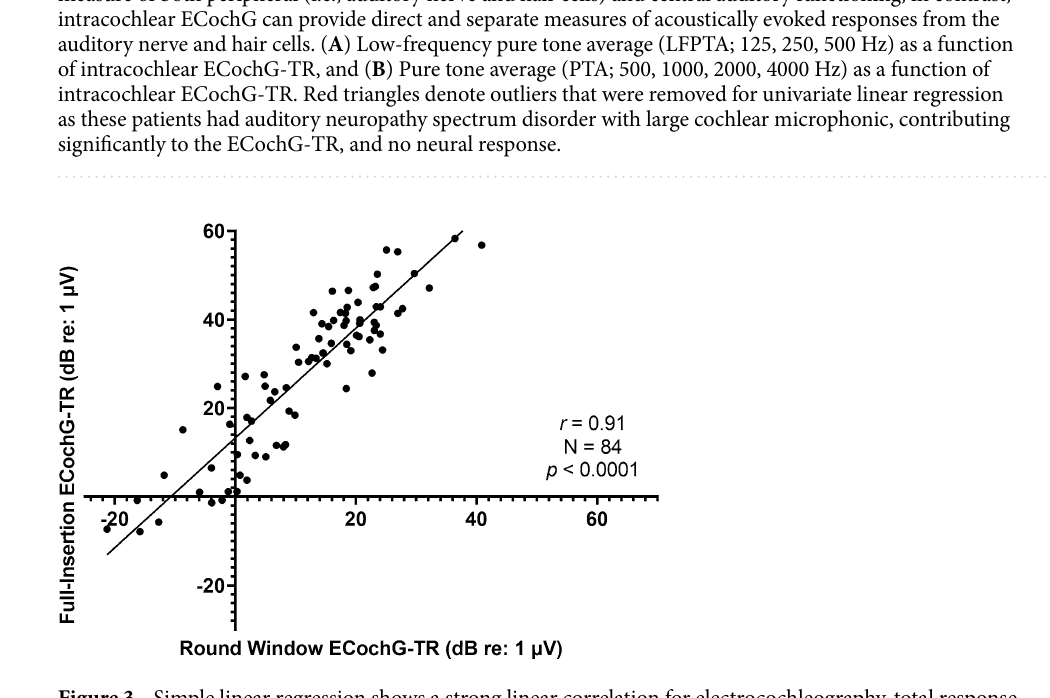
Figure 3. Simple linear regression shows a strong linear correlation for electrocochleography-total response (ECochG-TR) between round window and full insertion performed intraoperatively at the time of cochlear